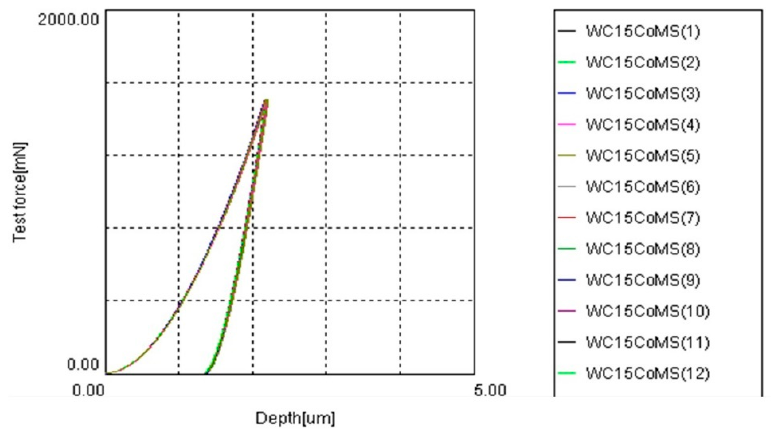
Figure 13. The force-indentation depth curves of substrate SH-15.